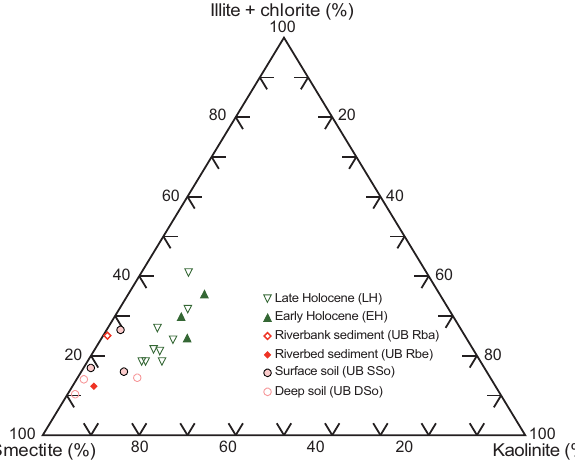
Figure 2. Phyllosilicate mineral composition of the Godavari River basin and offshore